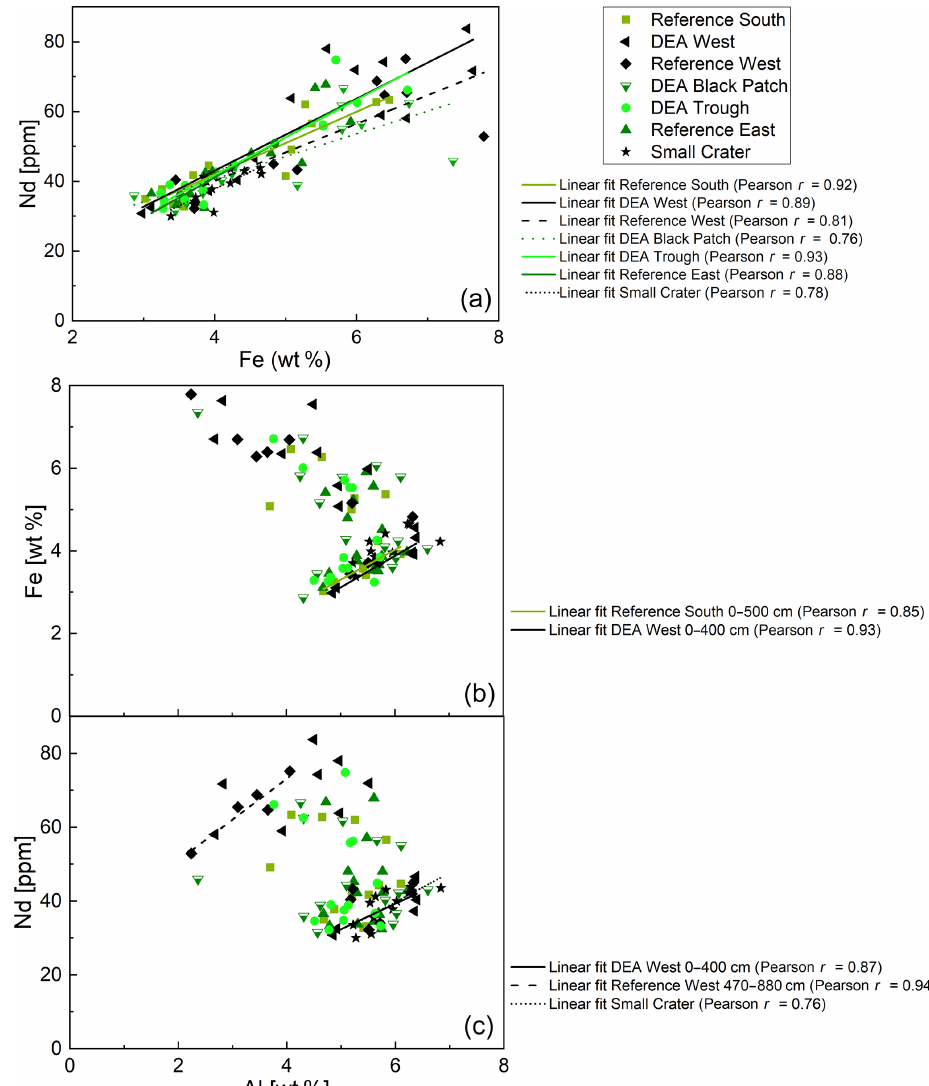
Figure 11. (a) Fe–Nd plot and correlations for all cores. Pearson r coefficients show positive correlations of REY with Fe for all cores. (b) Al–Fe plot. Only positive correlations for the upper parts of Reference South and DEA West are shown. (c) Al–Nd plot. Only positive correlations for the upper part of Reference South, as well as for the lower part of Reference West and the entire Small Crater core are